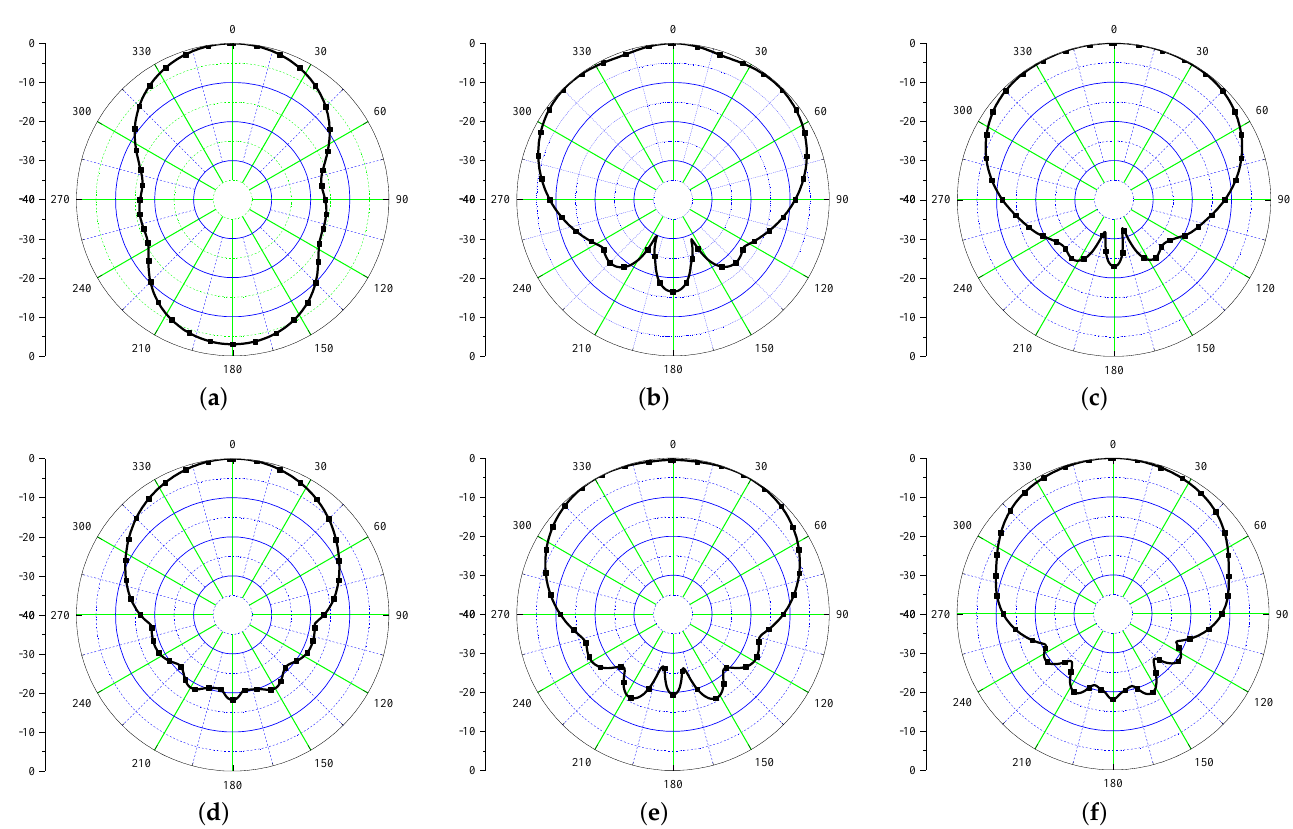
Figure 14. Simulated radiation patterns of conformal antenna (xz plane) at ( a ) 868 MHz ( b ) 3 GHz ( c ) 3.5 GHz ( d ) 4 GHz ( e ) 4.5 GHz ( f ) 5 GHz.